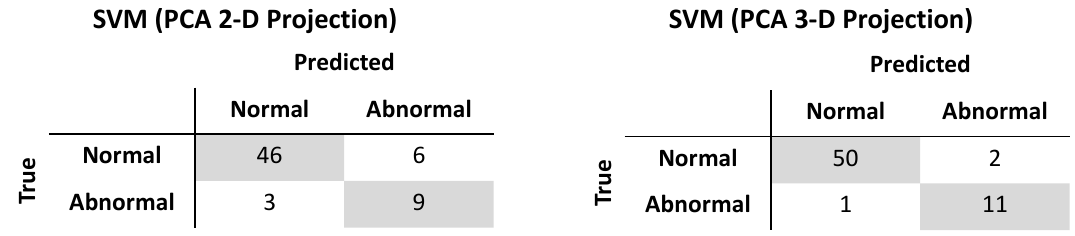
Figure 5. Test set performance of support vector machine classifiers trained after projection by principal components analysis onto two-dimensional ( left ) and three-dimensional ( right ) subspaces.